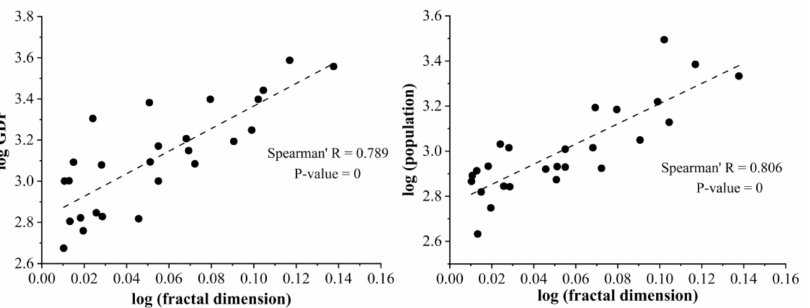
Figure 3. Fitting results between fractal dimensions of metro networks and urban size.